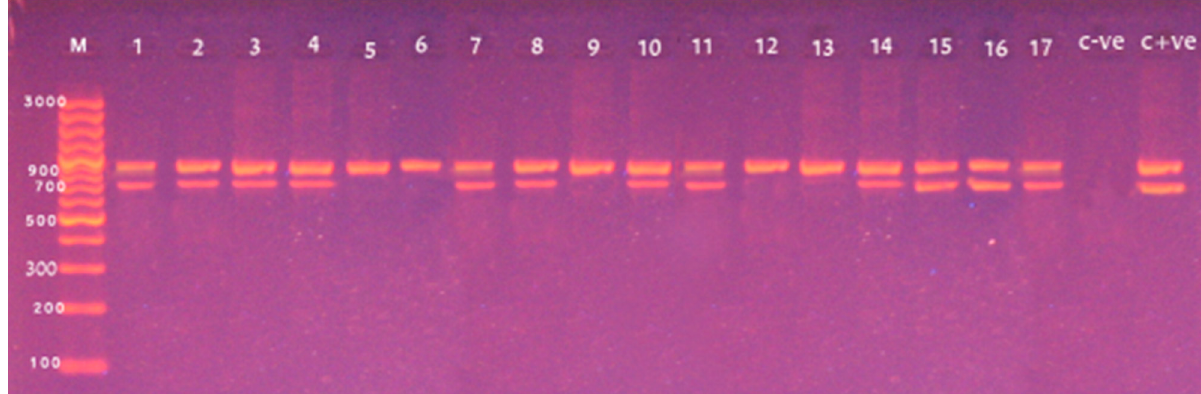
Figure 2. Amplification of 16S rRNA and hlyA genes of L. monocytogenes at 938 bp and 702 bp, respectively, by multiplex PCR. Lane M: 100 bp DNA ladder; Lane 1–17 positive samples for 16S rRNA ; Lane 1–3 (raw milk), 4, 7–8 (fish fillet), 10–11 (sausage) and 14–17 (minced meat) were positive for the hlyA gene; Lane C − ve: Control Negative; Lane C +ve: Control Positive.